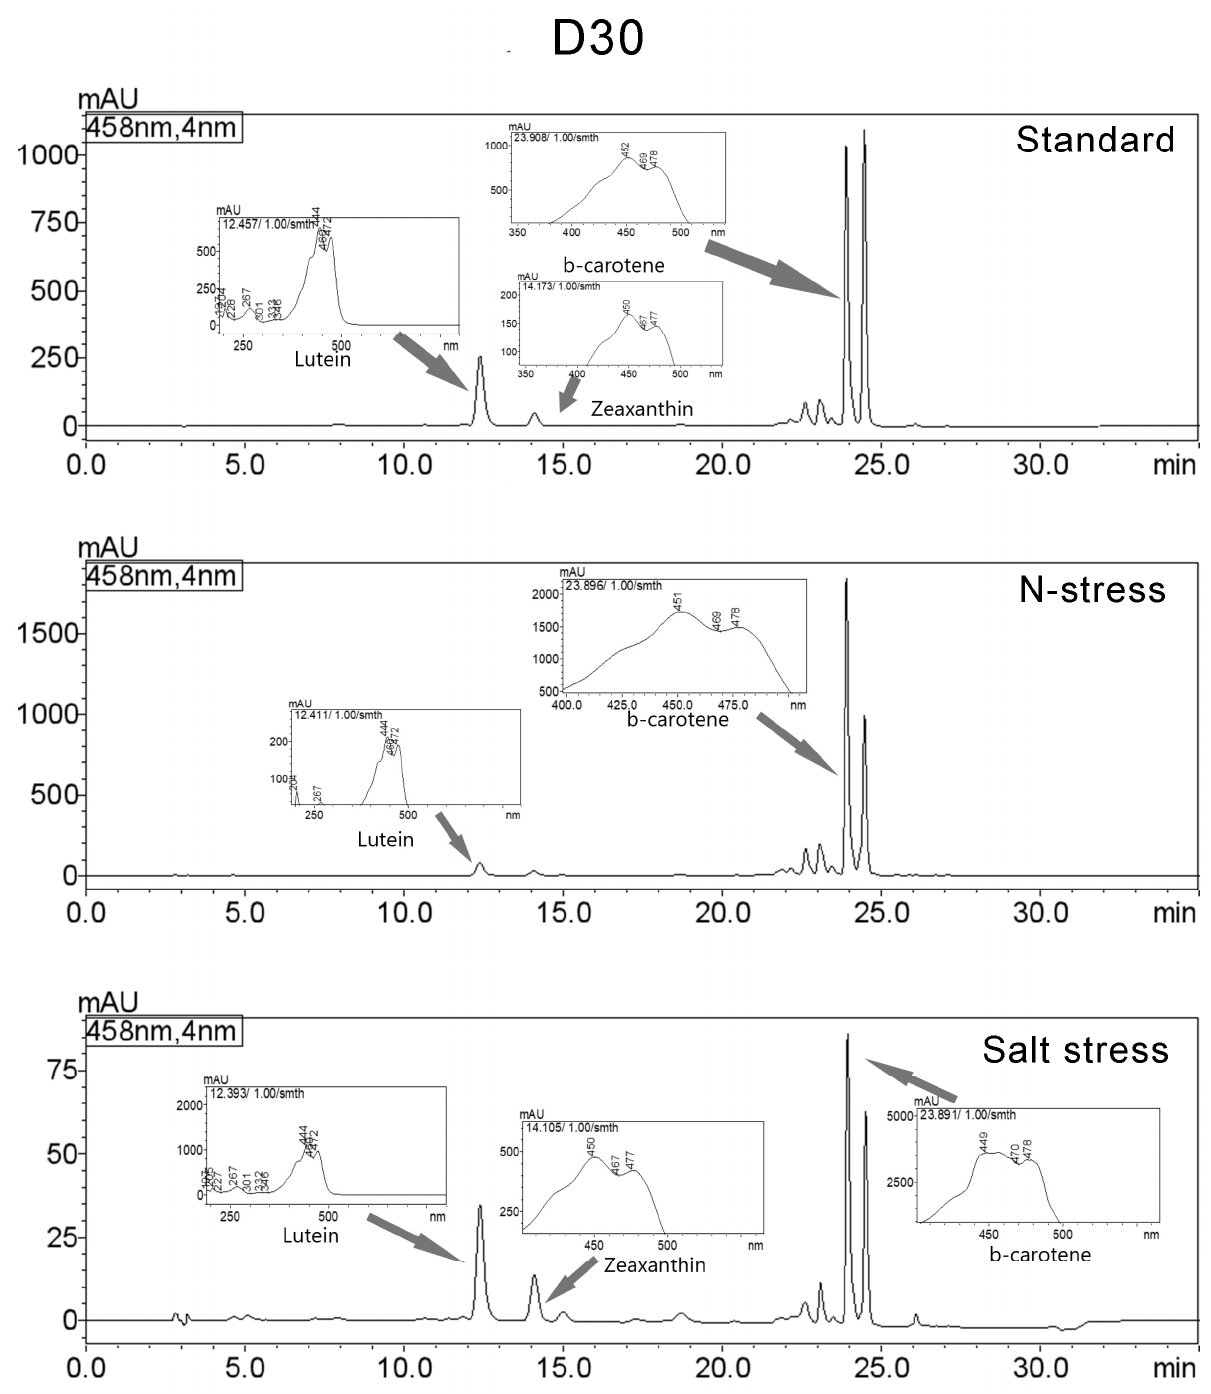
Figure 8. HPLC chromatographs of the Dunaliella salina AthU-Al D30 (D30) strain cultivated in standard conditions, under nitrogen deprivation (N-stress) and under high salinity (salt stress). Lutein, zeaxanthin and β -carotene peaks are marked on the chromatographs.